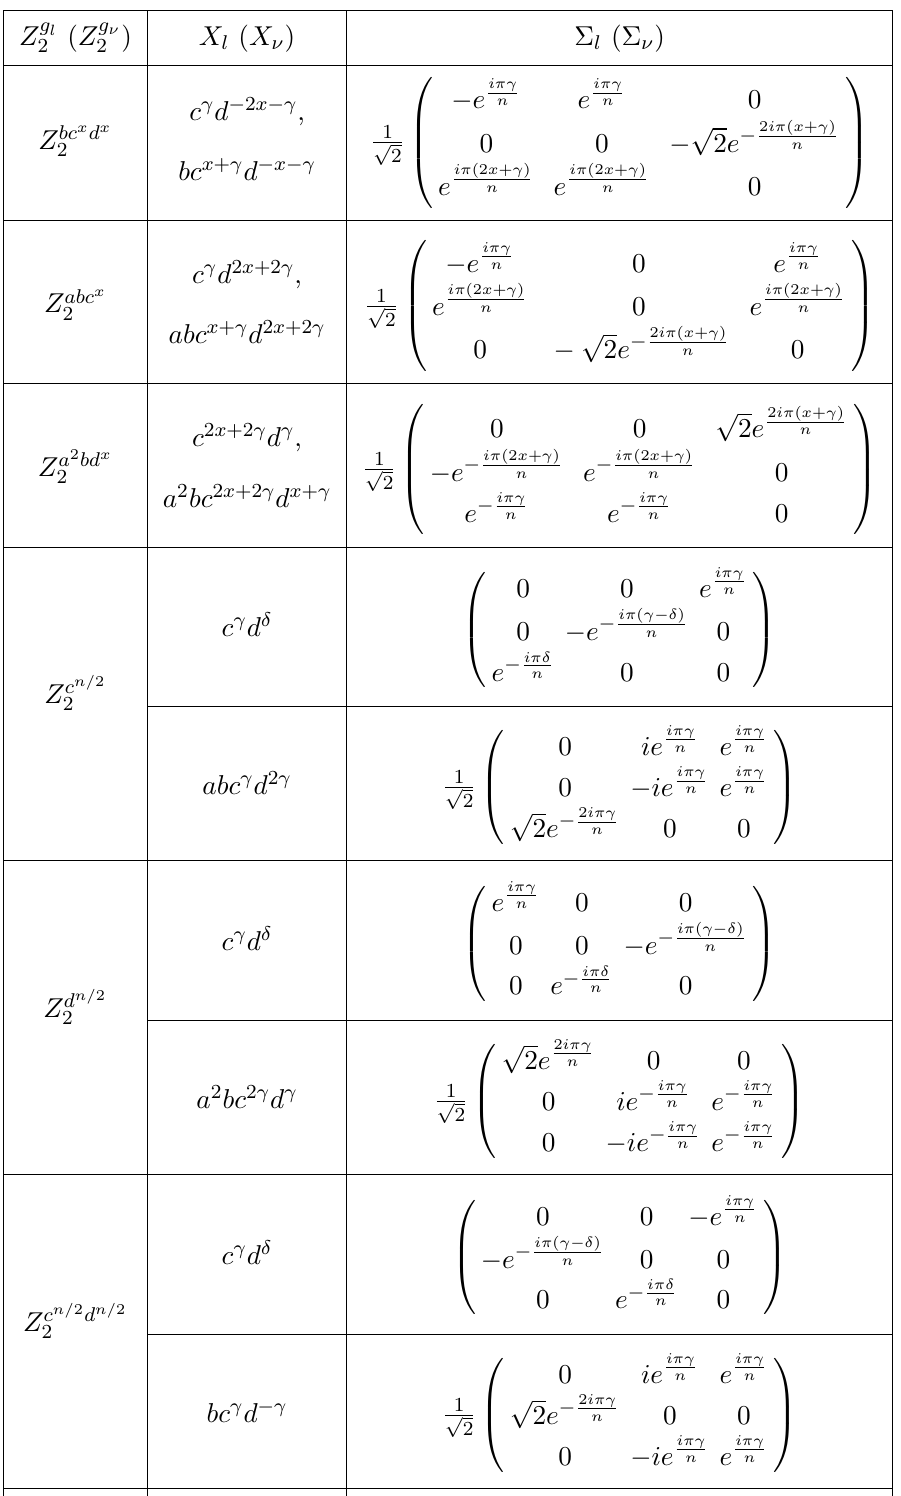
Table 1 . The possible residual subgroups of the structure Z 2 (cid:2) CP and the corresponding Takagi factorization matrices, where the parameters x , (cid:13) , (cid:14) can take the values of 0 ; 1 ; : : : ; n (cid:0) 1.